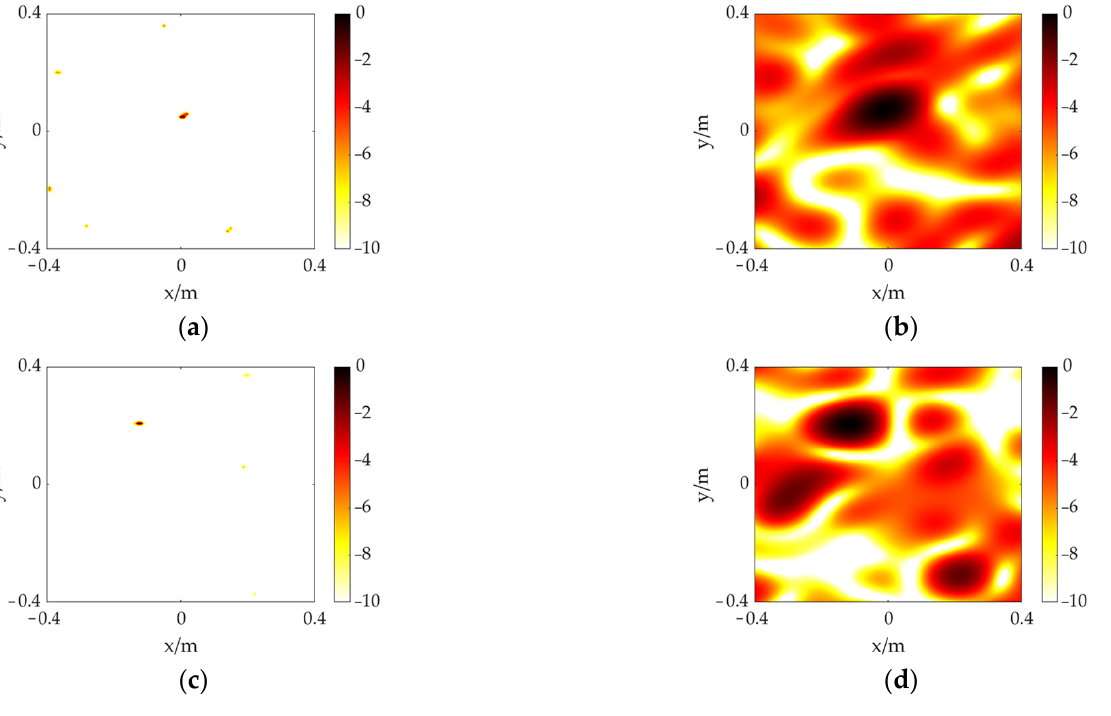
Figure 8. The experiment results of an acoustic source produced by an ultrasonic transducer at different positions. ( a ) FFT ‐ FISTA, (0, 0); ( b ) CSIF, (0, 0); ( c ) FFT ‐ FISTA, ( − 0.10, 0.20); ( d ) CSIF, ( − 0.10, 0.20).